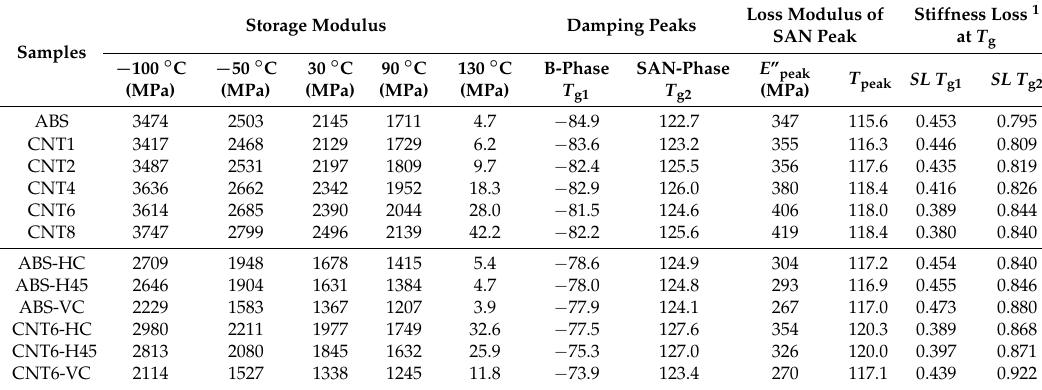
Table 8. Dynamic mechanical properties of neat ABS and its nanocomposites as measured on filaments and FDM